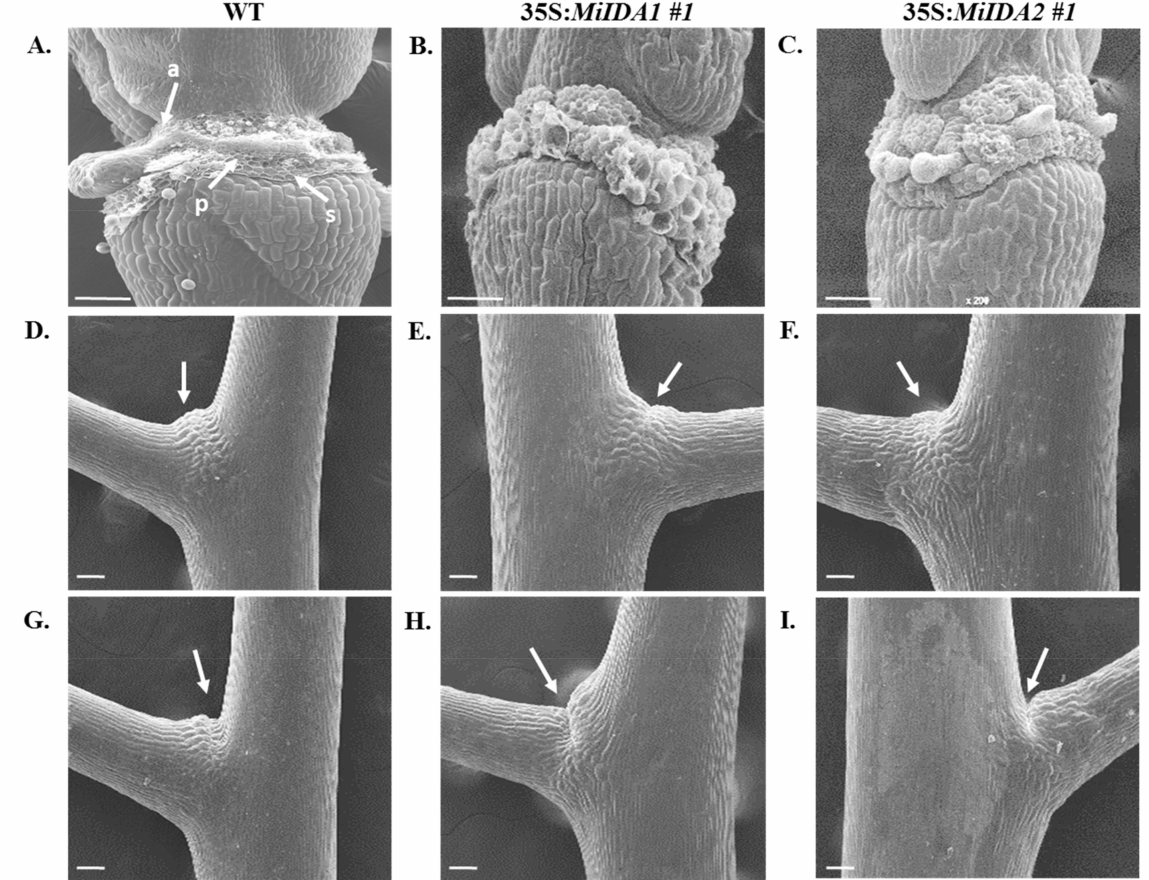
Figure 9. Scanning electron micrographs of floral and pedicel vestigial AZs. Floral parts after abscission at the AZs of ( A ) WT, ( B ) 35S: MiIDA1, and ( C ) 35S: MiIDA2 . AZ sites of sepals (s), petals (p), and anthers (a) are denoted. ( D ) WT, ( E ) 35S: MiIDA1 and ( F ) 35S: MiIDA2 young (P5-P7) pedicel vestigial AZs. Arrows denote a small cleft developed on the upper side of the pedicel. ( G ) WT, ( H ) 35S: MiIDA1 and ( I ) 35S: MiIDA2 old (P8-P10) pedicel vestigial AZs. Arrows denote an invasive developed cleft on the upper side of the pedicel. All scale bars = 100 µ m. The images presented for each WT plant or overexpression line are representative images of 3 or 4